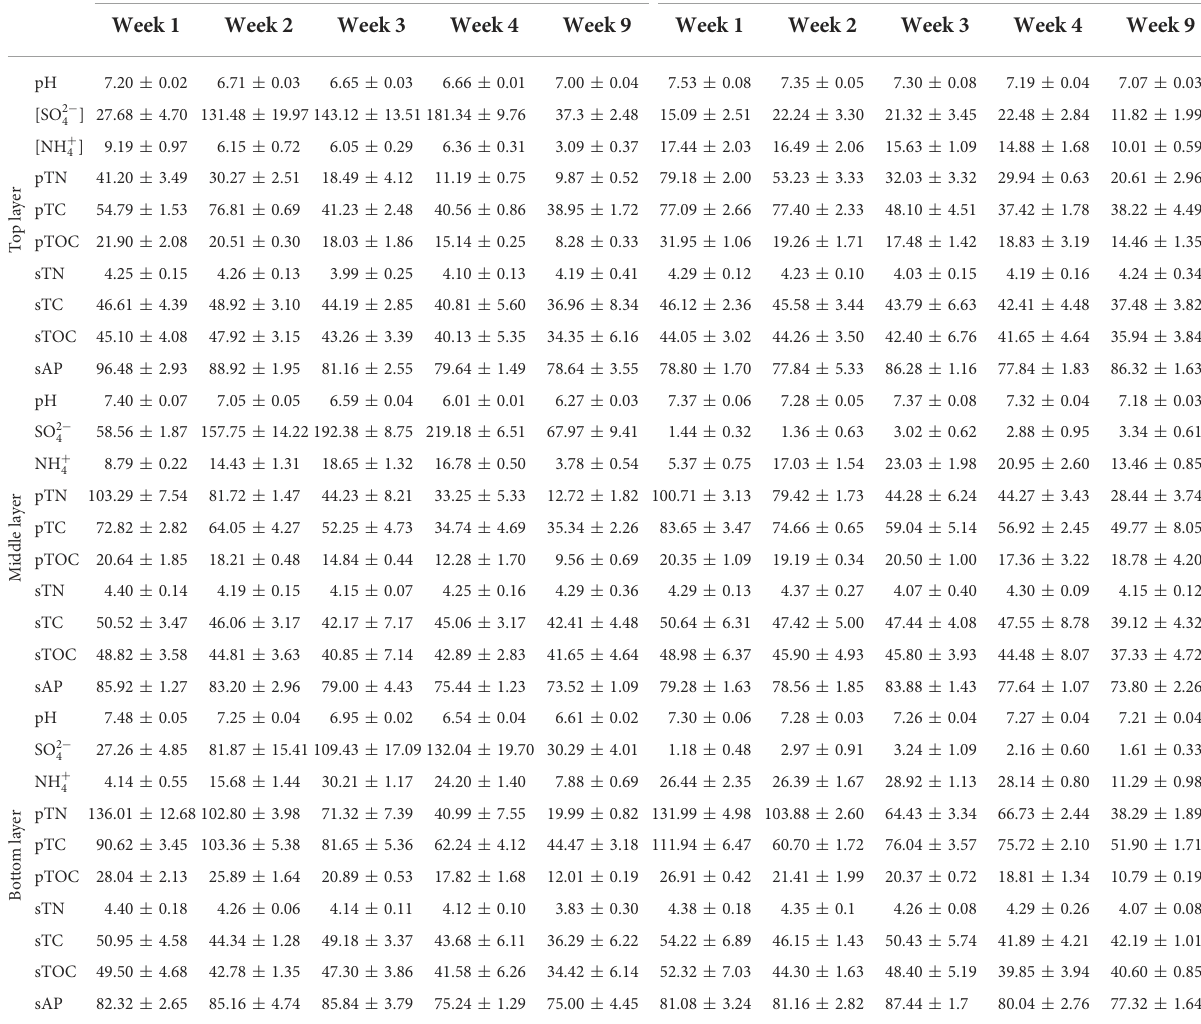
TABLE 1 Chemical properties of porewater and